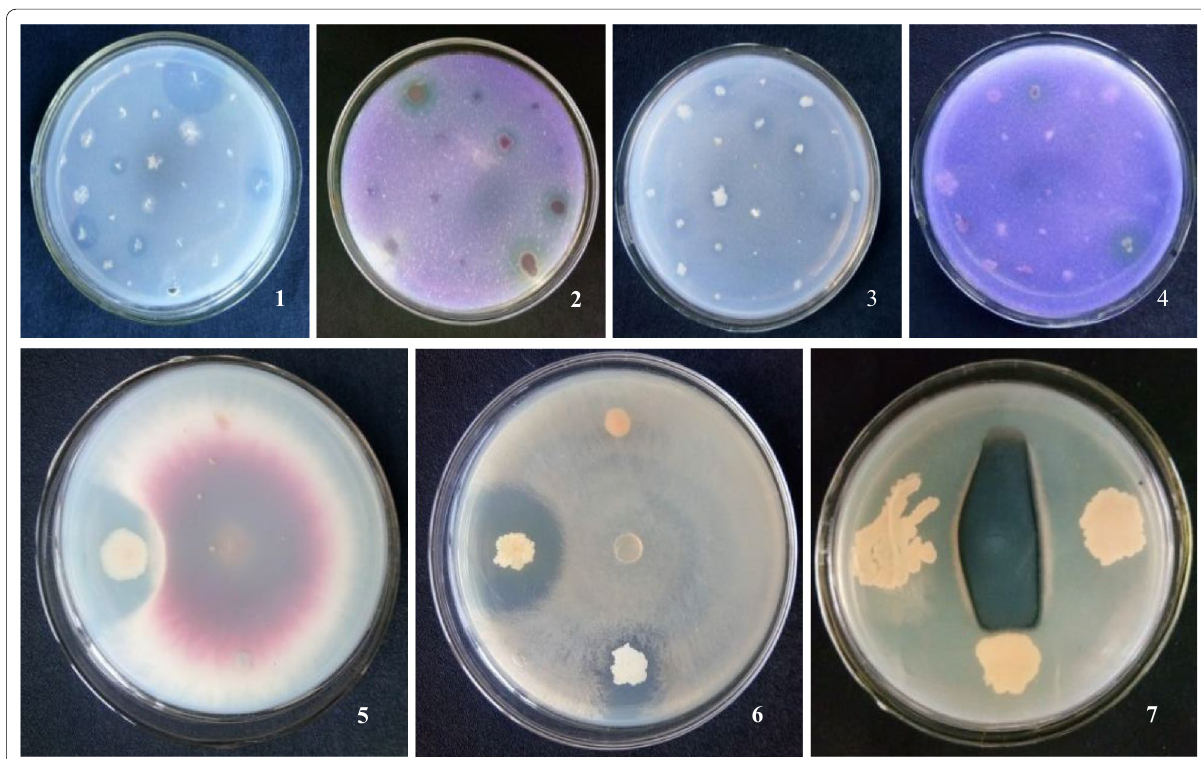
Fig. 1 Growth of endophytic bacteria on different culture media showing nitrogen fixing (1), calcium phosphate (2), calcium phytate (3) and potassium (4) solubilizing activities and the antagonistic activity against Fusarium graminearum (5), Rhizoctonia solani (6) and Exserohilum turcicum